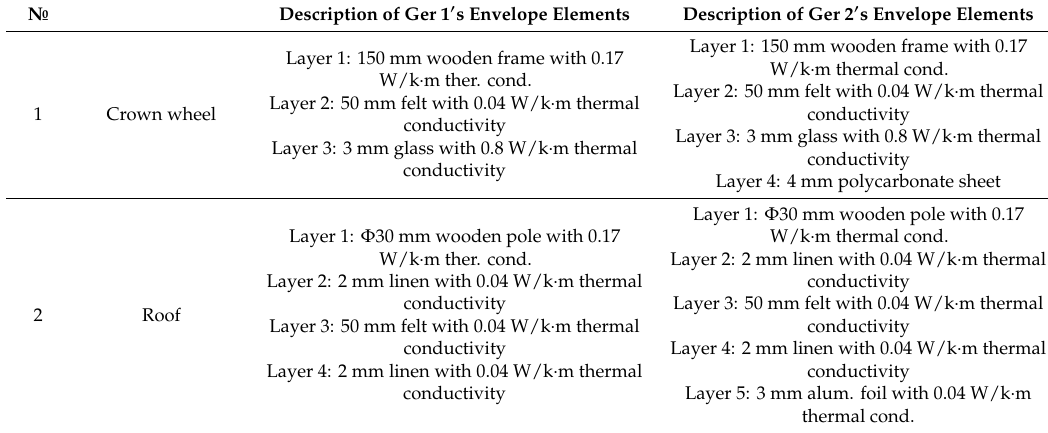
Table A1. The thermal and technical descriptions of envelope materials used in Gers 1 and